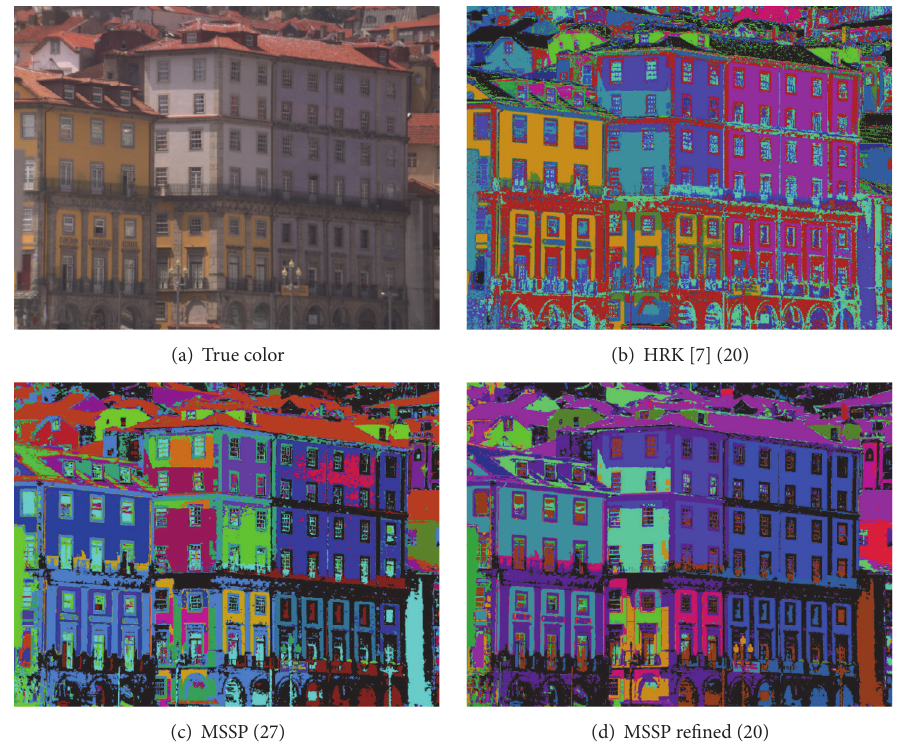
Figure 8: Clustering results on Ribeira image. The number of clusters is shown in parentheses in the respective